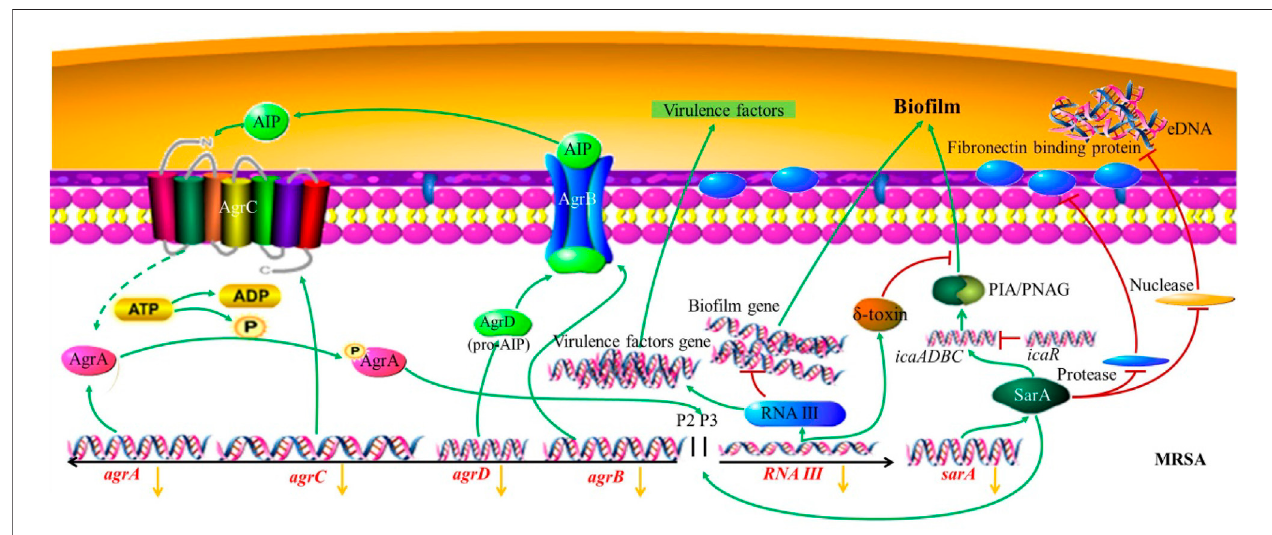
FIGURE7| MRSA bio fi lmregulated bytheQSsystem. Theyellow arrow indicates thatthecombined action ofRYNand LNZ leadstoadecrease intheexpression of the